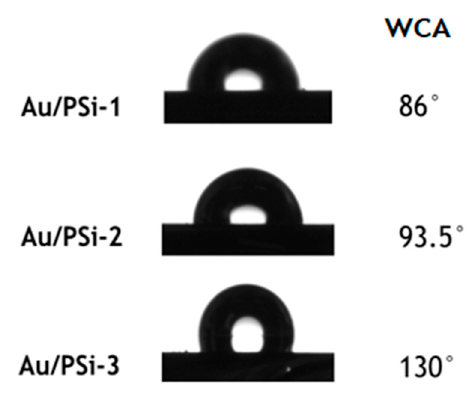
Figure 2. The water contact angle (WCA) of the drops placed onto the surface of Au/PSi-1,2,3.